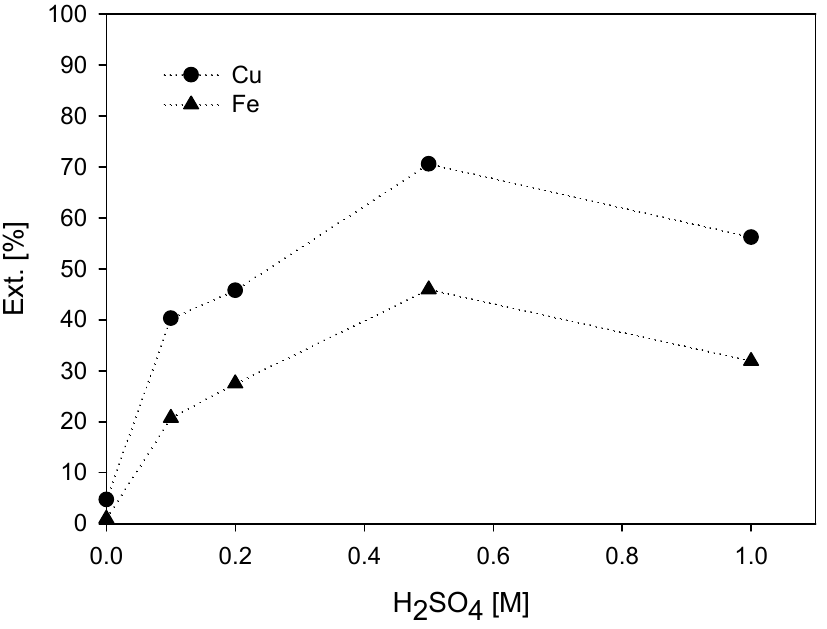
Figure 14. Effect of acid concentration on metal extraction. ( • ) = Cu; ( ▲ ) = Fe. [Test conditions: KI = 100 ppm, T= 45 °C in seawater, 450 rpm].